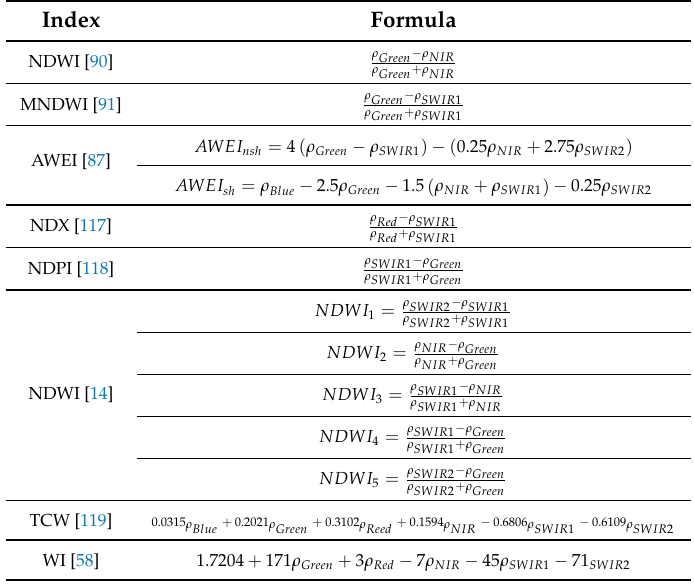
Table A3. Some of the water indexes used to extract water features on multispectral images: ρ indicates raw data (DN) or reflectance values from the different bands proposed for each